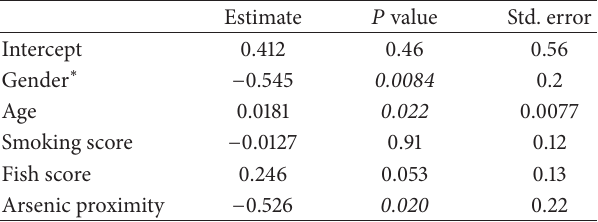
Table 2: Reduced model (multiple linear regression) for total blood